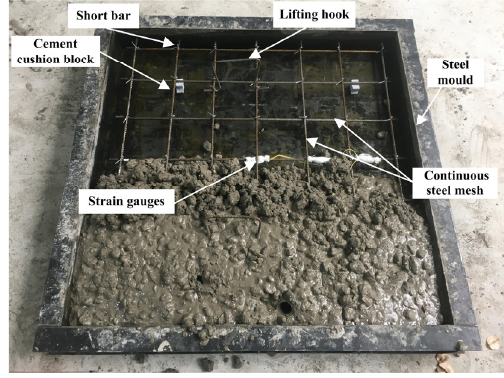
Figure 3. Casting of RCP specimen.